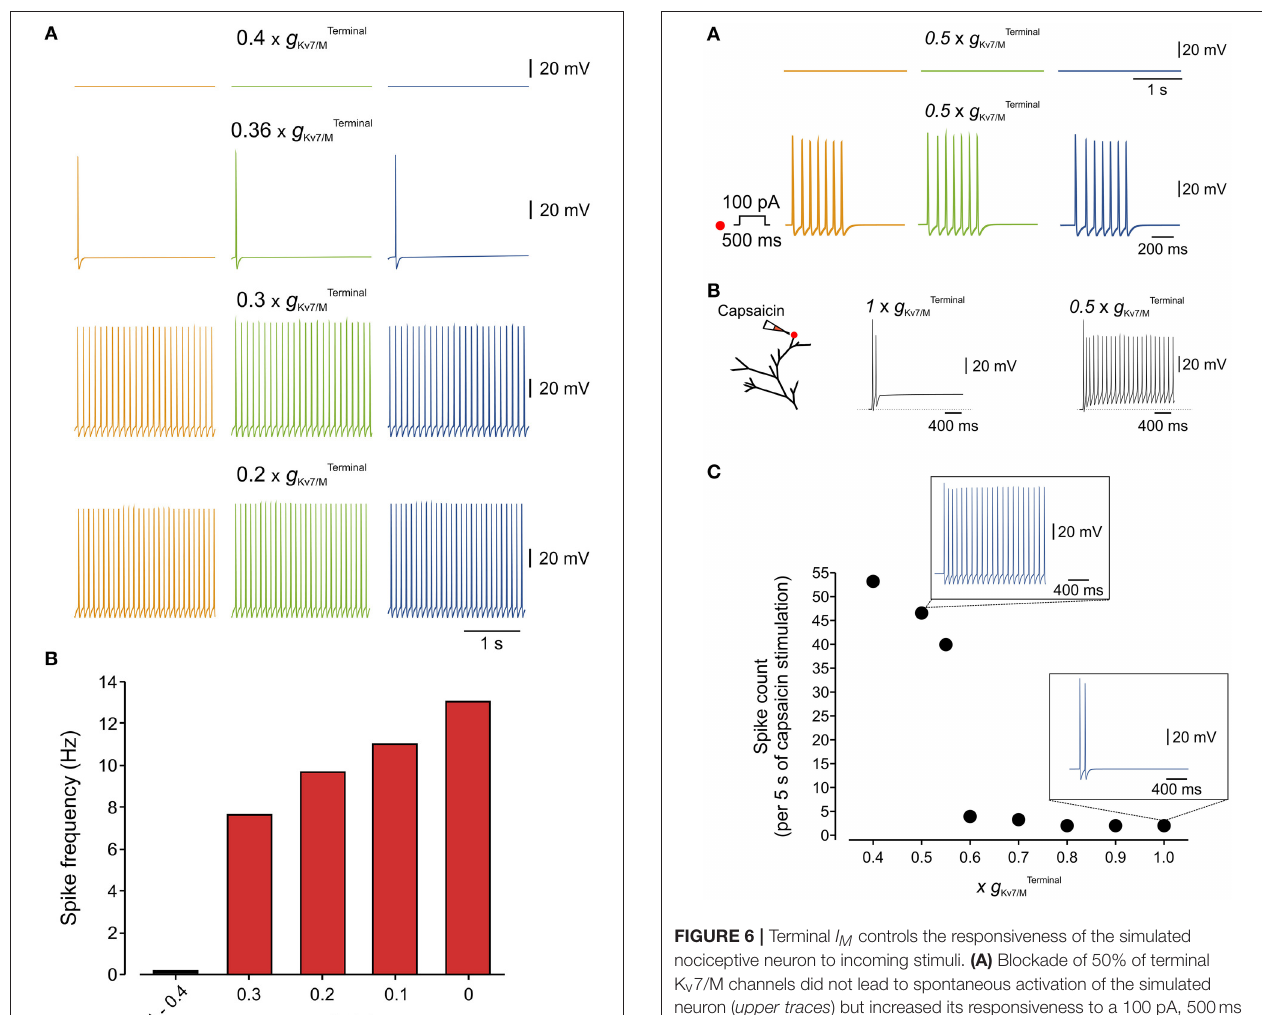
stimulation ( Figure 6B , left, red dot), while varying the g Terminal